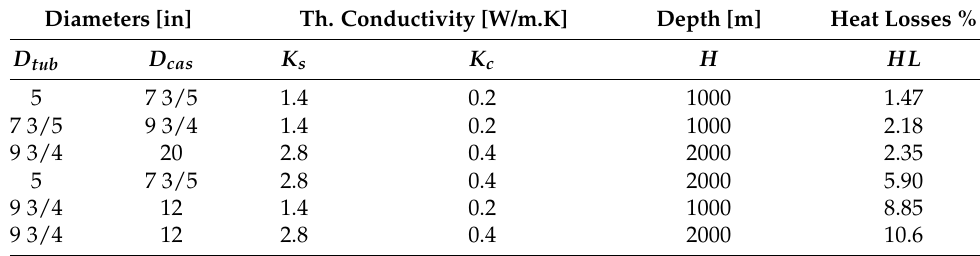
Table 3. Heat losses in the wellbore during 6 months (one injection cycle). Diameters [in] Th. Conductivity [W/m.K] Depth